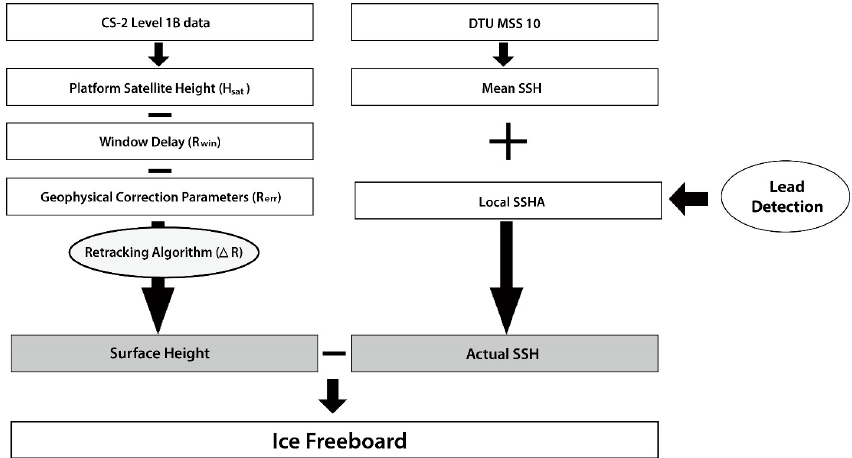
Figure 2. The sea ice freeboard processing procedure using CryoSat-2 data.